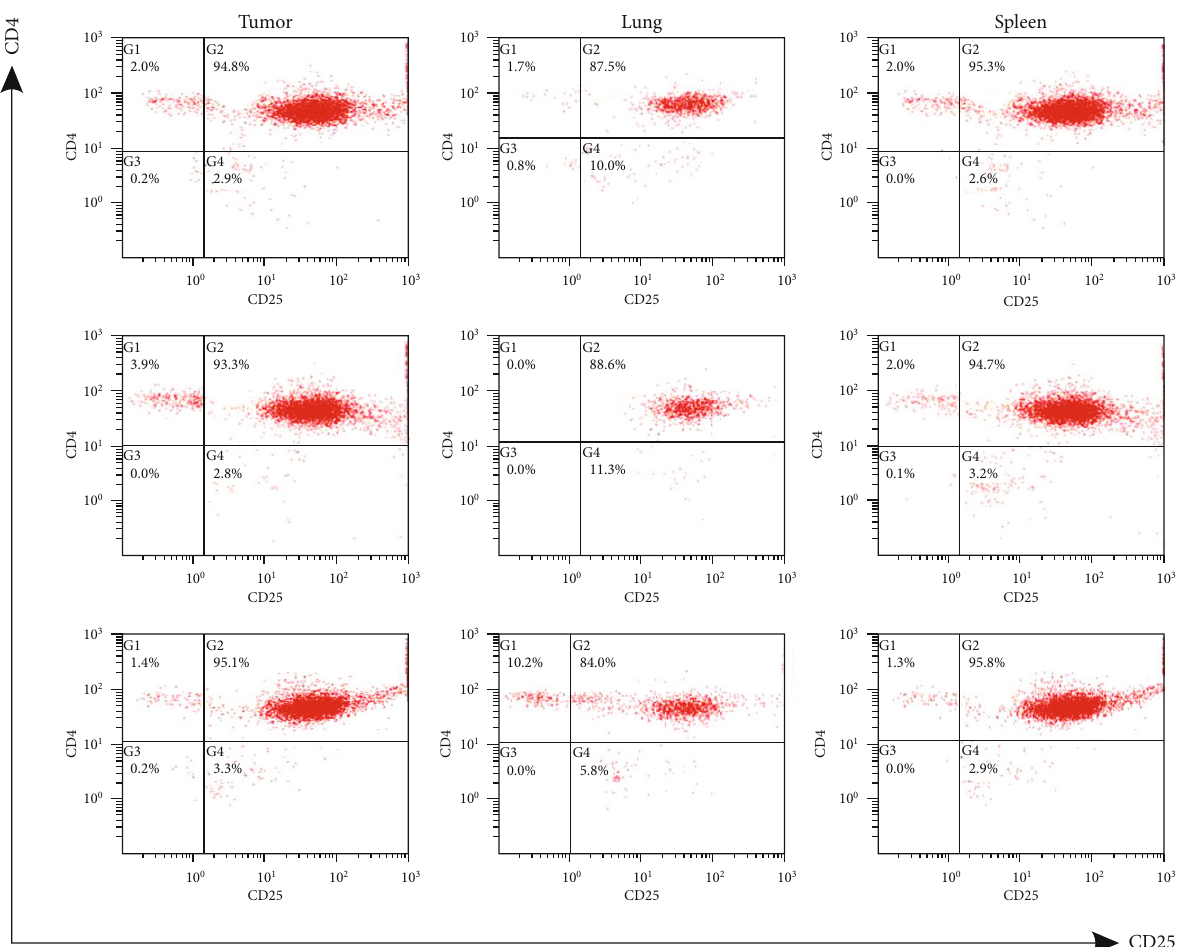
Figure 2: FCM detection of breast tumor tissues, lung metastatic tissues, and spleens sorted CD4 + CD25 + T cells in three 4T1 tumor-bearing BALB/c